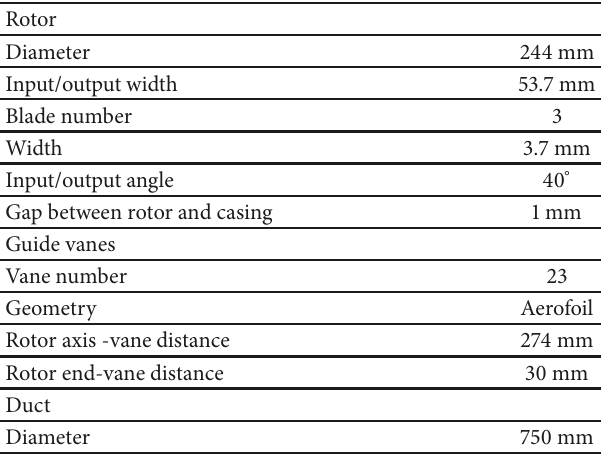
Table 2: Parameters of the biradial